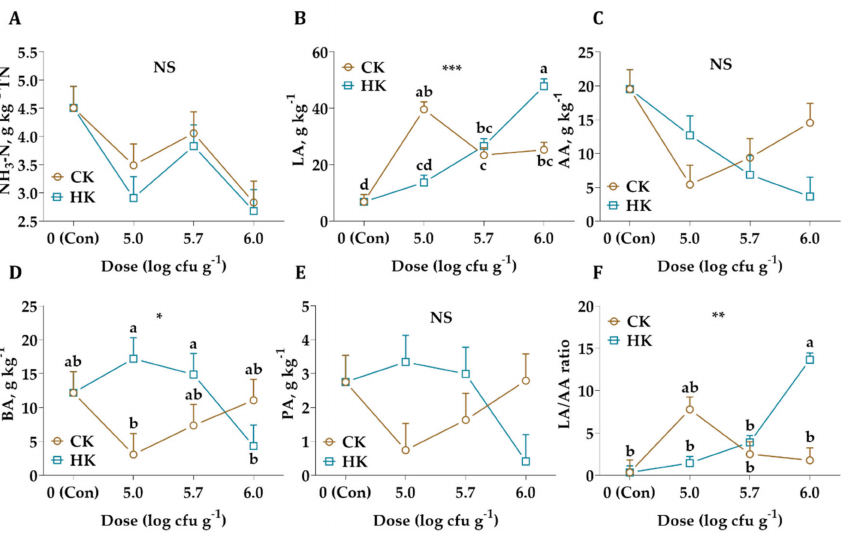
Figure 2. Changes in ammonia nitrogen (NH 3 -N, ( A )), lactic acid (LA, ( B )), acetic acid (AA, ( C